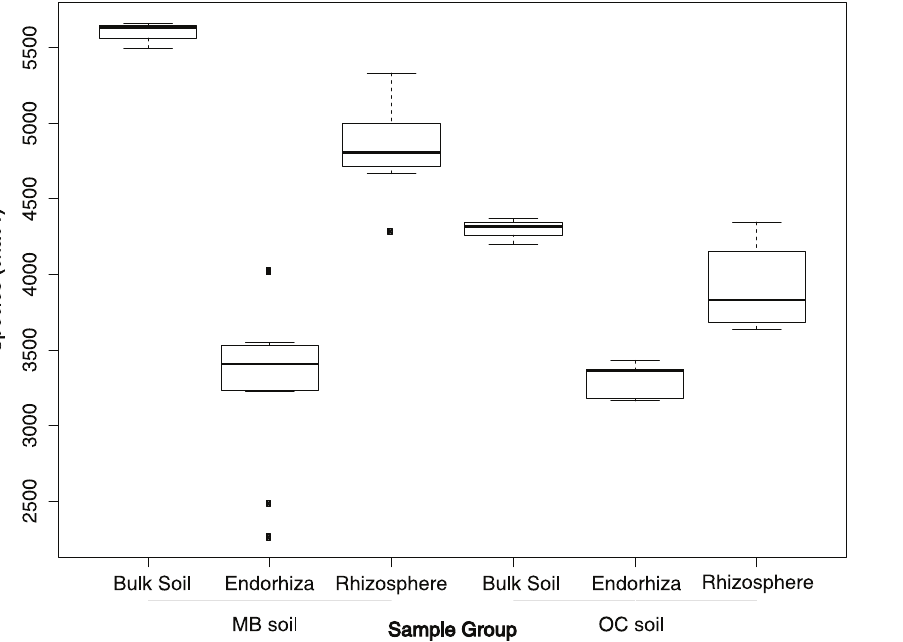
Figure 6. Box plots of alpha diversity (observed species) for endorhiza, rhizosphere, and bulk soil from two separate soil types in the second eperiment. MB = Mo-Bio soil, OC = Orange County soil. Note the significant differences between alpha diversity in the bulk soil and rhizosphere but negligible differences between endorhiza alpha diversity between soil types.